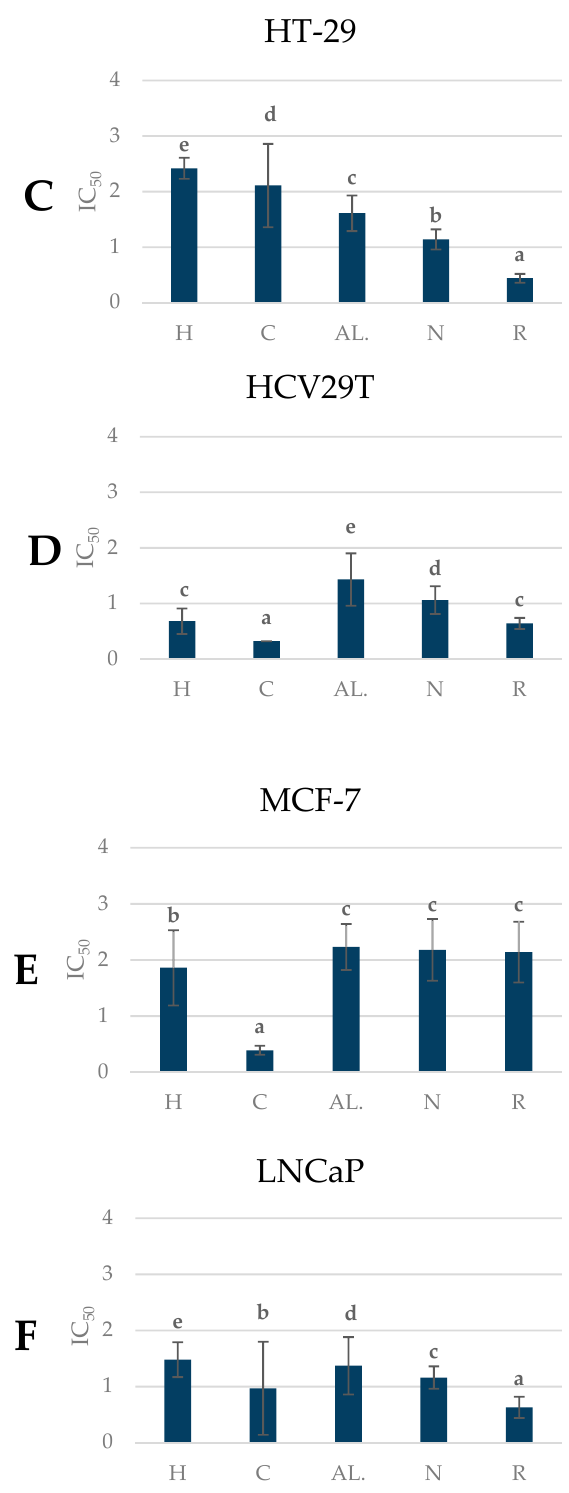
Figure 7. Antiproliferative properties of pear cultivars (IC 50 ). Varieties with di ff erent letters were significantly di ff erent at p = 0.05 according to Duncan’s test. The data are expressed as mean ± SD ( n = 9). H—Hortensia, C—‘Conference’, AL.—‘Alexander Lucas’, N—‘Nojabrska’, R—‘Radana’. ( A ) A549 – human lung cancer; ( B ) A498 – human kidney cancer; ( C ) HT ‐ 29 ‐ colon adenocarcinoma; ( D ) HCV ‐ 29T ‐ bladder cancer; ( E ) MCF ‐ 7 ‐ human